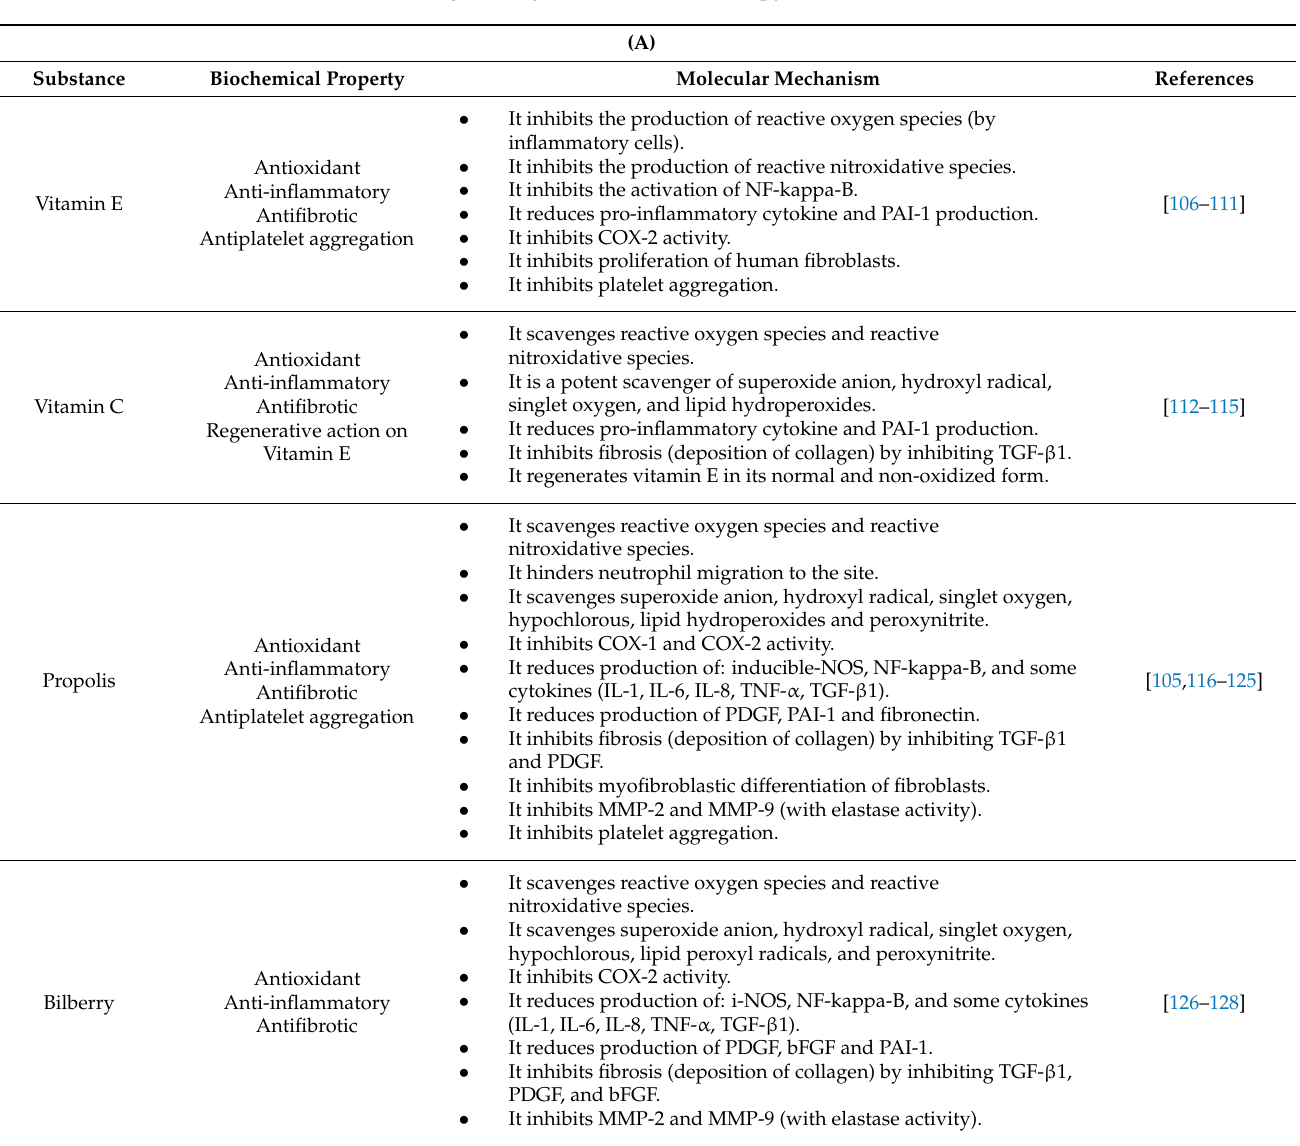
Table 2A,B list the antioxidants we use in our multimodal treatment: vitamin E, vitamin C, propolis, bilberry, silymarin, Ginkgo biloba, carnitine, coenzyme Q10, boswellia, pentoxifylline, superoxide dismutase, hyaluronic acid, diclofenac. Table 2A,B also report the biochemical properties and mechanisms of action of the listed antioxidant substances [101,102,106–167]. Table 2. ( A ). Biochemical properties and molecular mechanisms of the substances used in the multimodal antioxidant therapy of Peyronie’s disease. Panel for effective understanding of “tar- geted antioxidant therapy” (Part 1). ( B ). Biochemical properties and molecular mechanisms of the substances used in the multimodal antioxidant therapy of Peyronie’s disease. Panel for effective understanding of “targeted antioxidant therapy” (Part